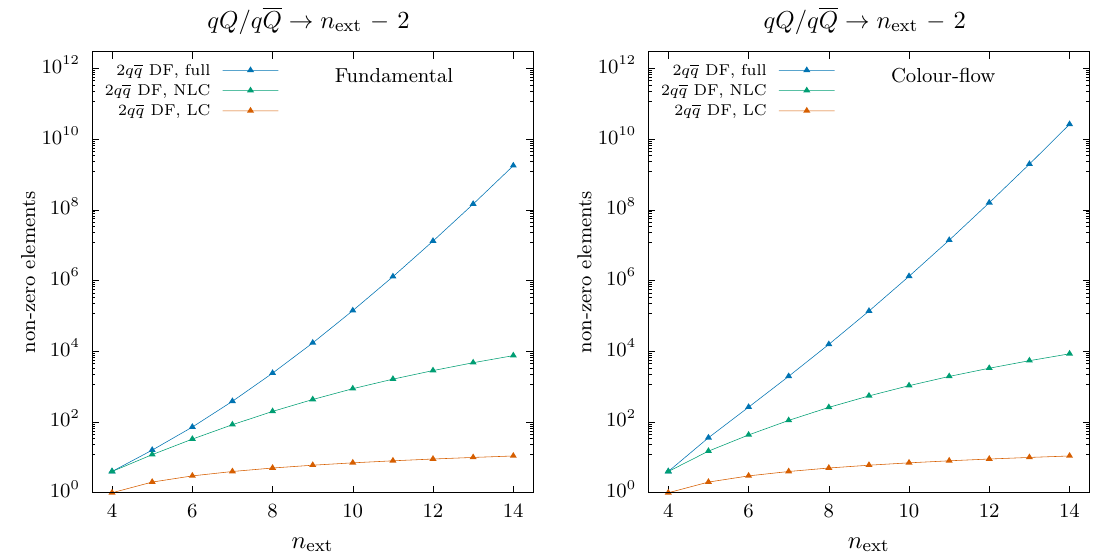
Figure 5 . Number of non-zero elements in the colour matrix at LC (red), NLC (green) and full colour (blue) for qQ/qQ initial state in fundamental (left) and colour-flow decomposition (right) for the two-quark-pair distinct-flavour channel (triangle).